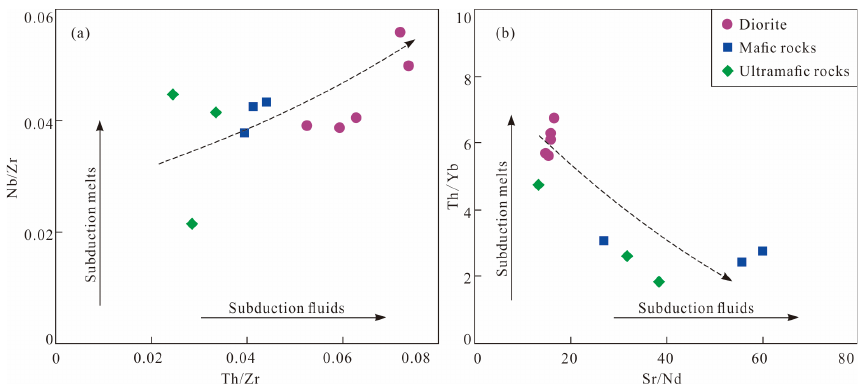
Figure 10. Diagrams of ( a ) Th/Zr versus Nb/Zr (modified after [96]) and ( b ) Sr/Nd versus Th/Yb (modified after [97]) of the mafic–ultramafic rocks, showing the addition of slab ‐ derived melts or sediment contaminants in mantle sources.